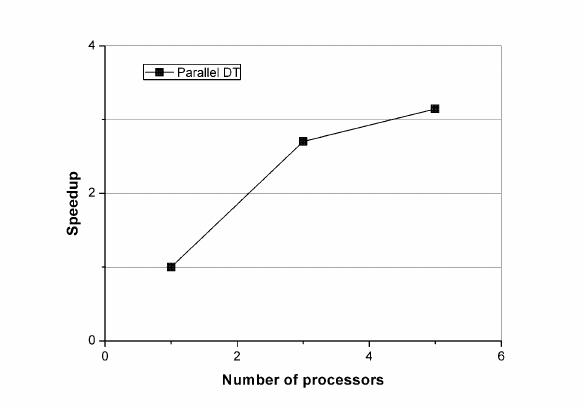
Figure 8. Speedup of parallel DT in this